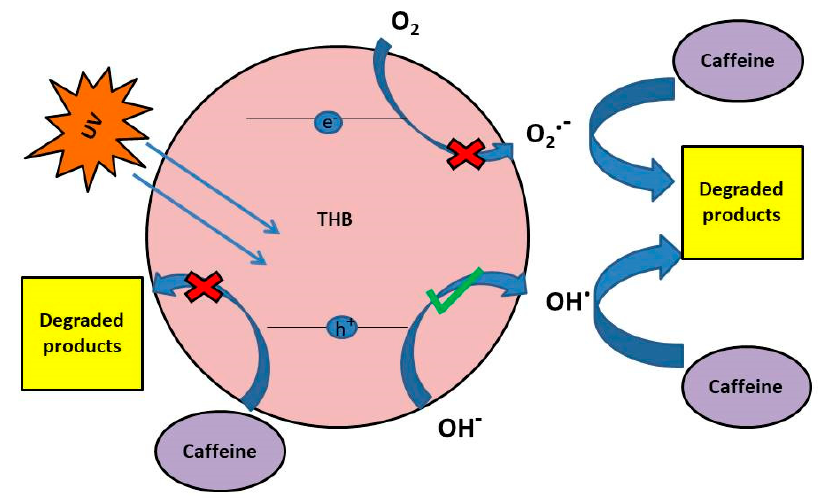
Figure 10. Schematic representation of phototcatalytic degradation of